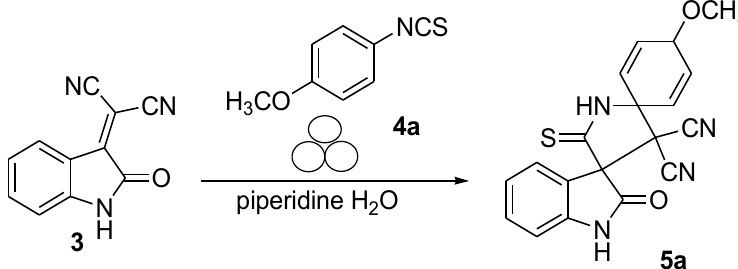
Table 2. Optimization of the model reaction conditions for (Step A).